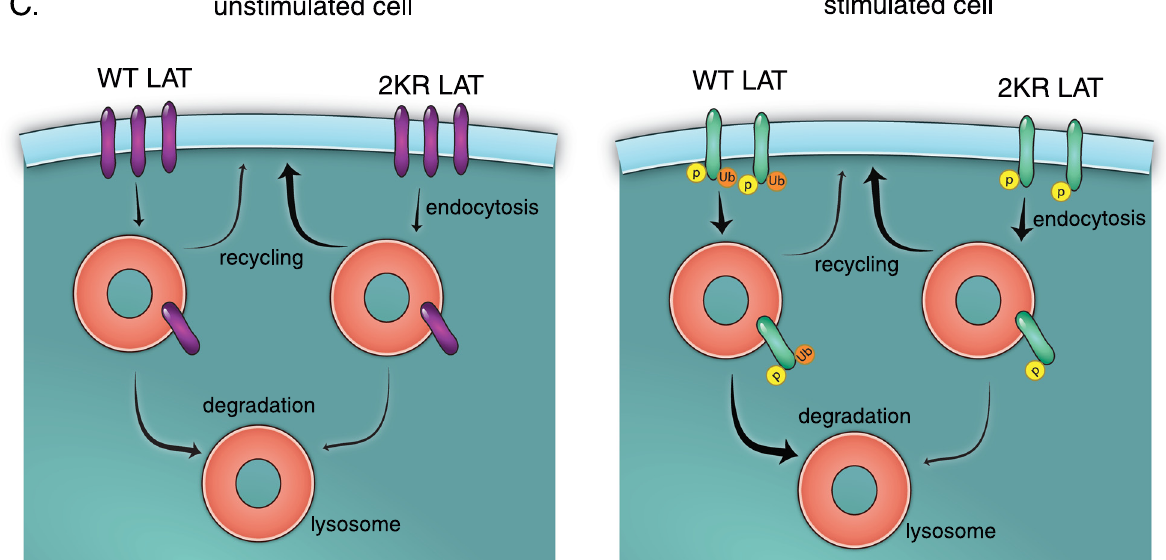
PLOS ONE | https://doi.org/10.1371/journal.pone.0229036 February 21,